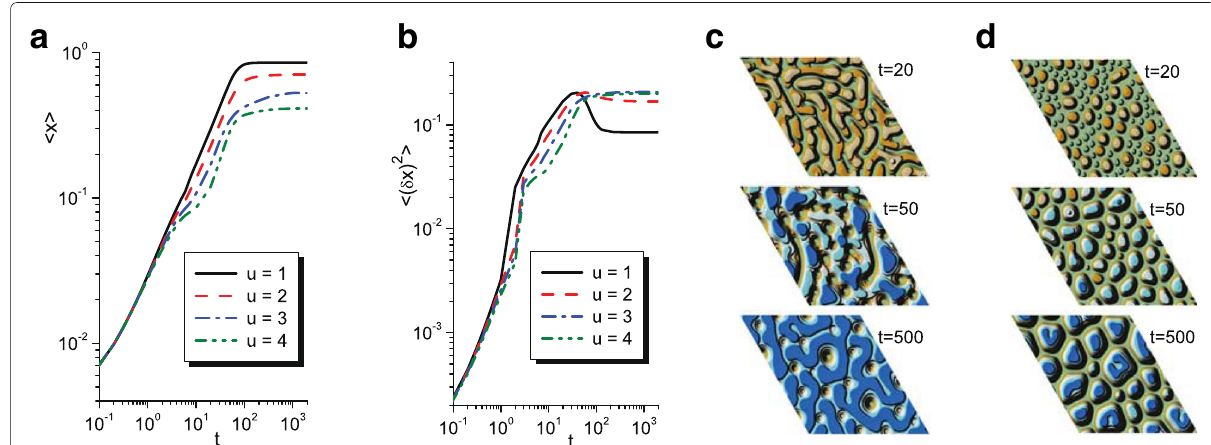
Fig. 1 Results of numerical simulations of adsorbate self organization in plasma-condensate system. a Dynamics of the mean adsorbate concentration (cid:10) x (cid:11) at different values of anisotropy strength u . b Order parameter (cid:10) (δ x ) 2 (cid:11) at different values of anisotropy strength u . Snapshots of the system evolution in c isotropic system at u = 1 and d anisotropic system at u = 3